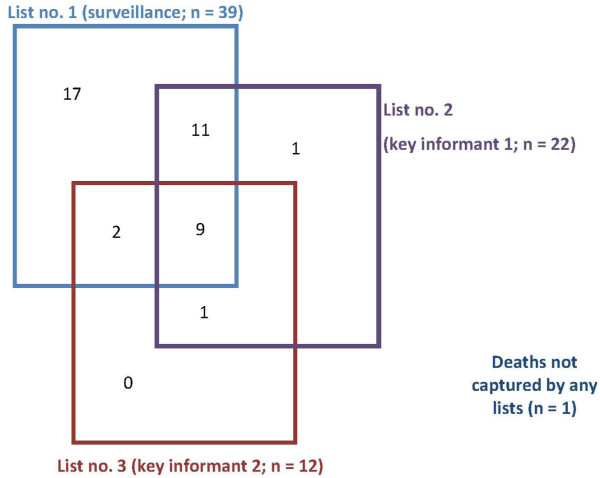
Venn diagram of the overlap in deaths reported among the three lists used for capture-recapture analysis.